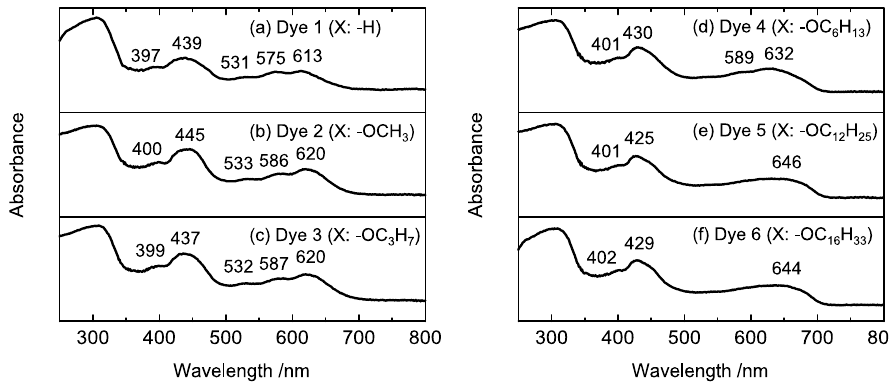
Figure 6. UV-vis absorption spectra of Pt (0.2 wt. %)/porphyrin dye (0.8 wt. %)/KTa(Zr)O 3 .